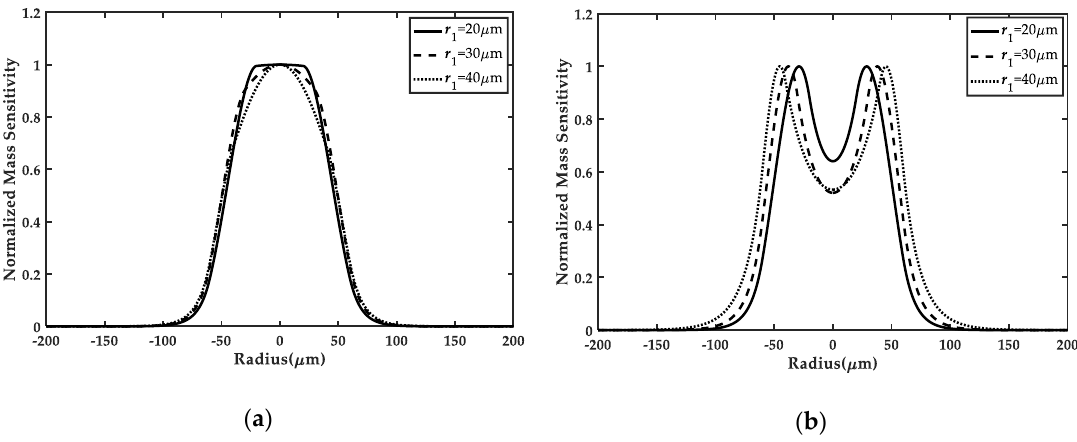
Figure 3. Comparison of the frame-like electrode FBAR ( a ) and the ring electrode FBAR ( b ) [20] for different r 1 , when r 2 is fixed as 60 µ m and (cid:101) R (cid:48) is equal to 0.04. With the decreasing of r 1 , the mass sensitivity distributions in the active region for the frame-like electrode become more uniform, but the distributions for the ring electrode are still concave.